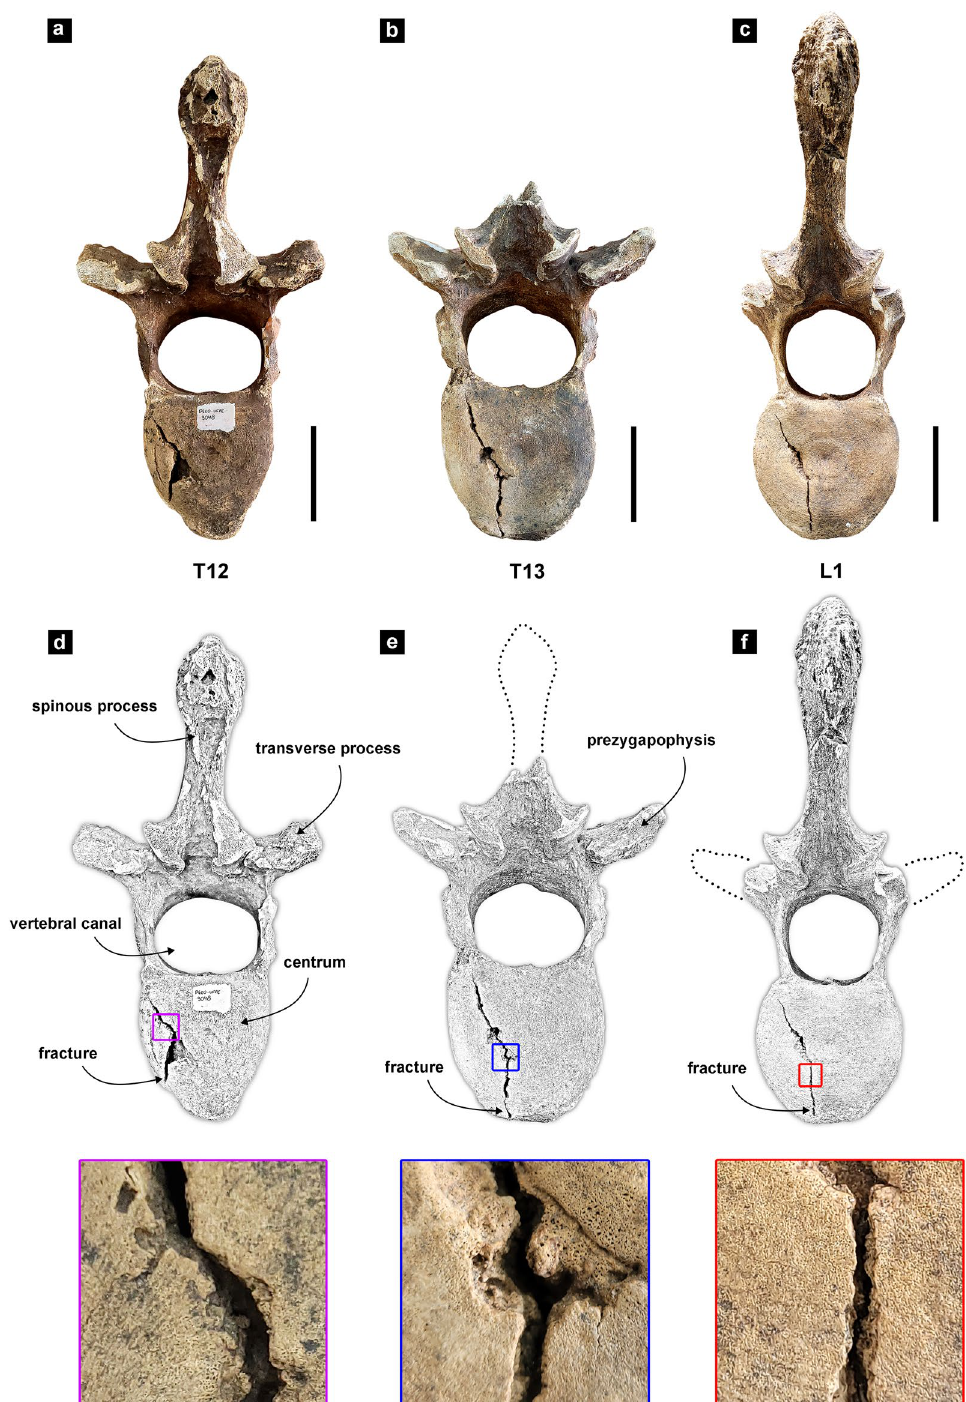
Figure 1. Thoracic T12 and T13, and lumbar L1 vertebrae of Eremotherium laurillardi . ( a–c ) Photography of T12, T13 and L1 in caudal view, ( d – f ) schematic drawing of vertebrae in caudal view and close-up view of the traumatic lesions. Scale bars: 10